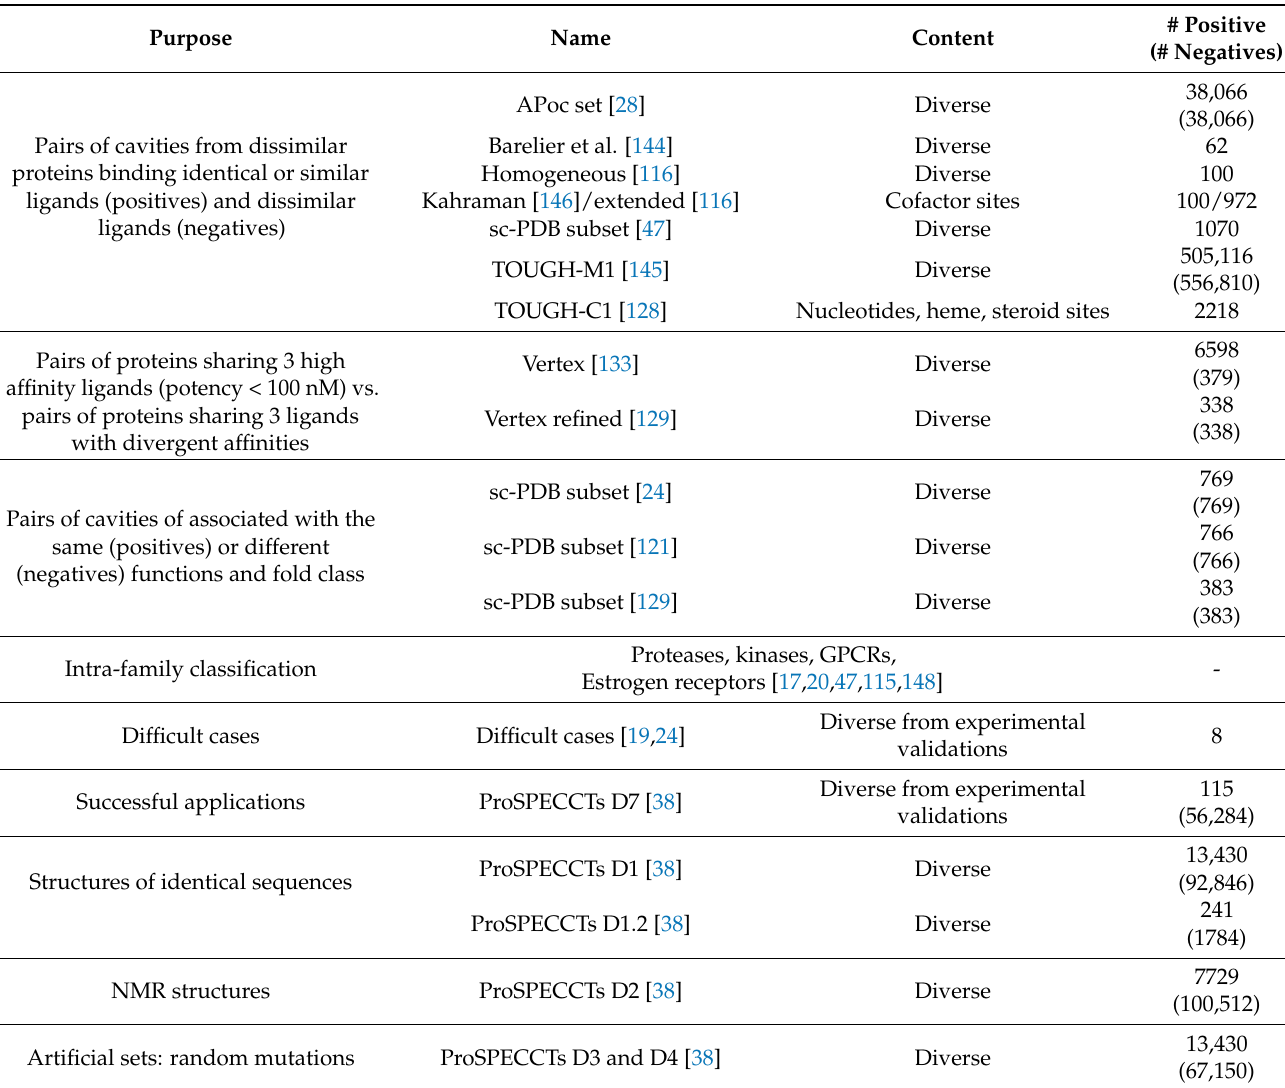
Table 4. Common datasets used in benchmarking studies for pocket